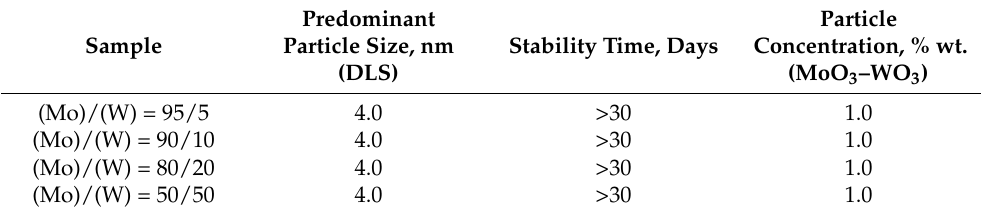
Properties of molybdenum–tungsten nanoparticle dispersions ((R)/(Me) =